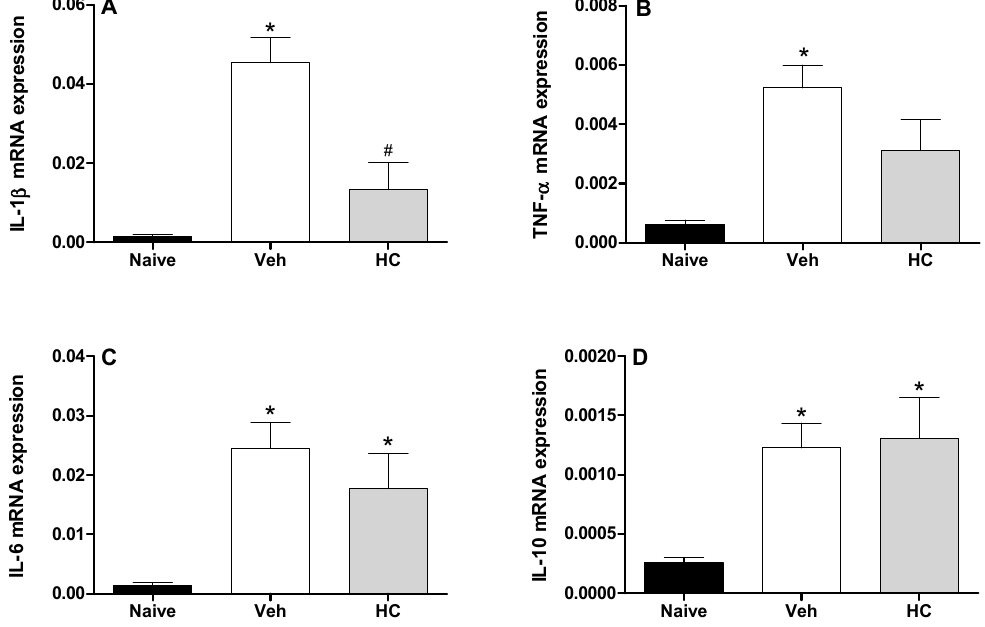
Figure 3. Effect of treatment with hecogenin acetate (HA) on IL-1 β mRNA ( A ), TNF- α mRNA ( B ), IL-6 mRNA ( C ), and IL-10 mRNA ( D ) paws levels. Mice were injected with HA (20 mg/kg) or vehicle (Veh; XX; control group) by the intraperitoneal route 30 min before the intraplantar injection of complete Freund’s adjuvant (CFA). The paw levels of cytokines were measured by Real Time PCR 2 h after the CFA injection. Data are reported as means ± SEM; n = 6 mice per group. * p < 0.05 vs. naive group; # p < 0.05 vs. vehicle-treated group, two-way ANOVA followed by Tukey’s